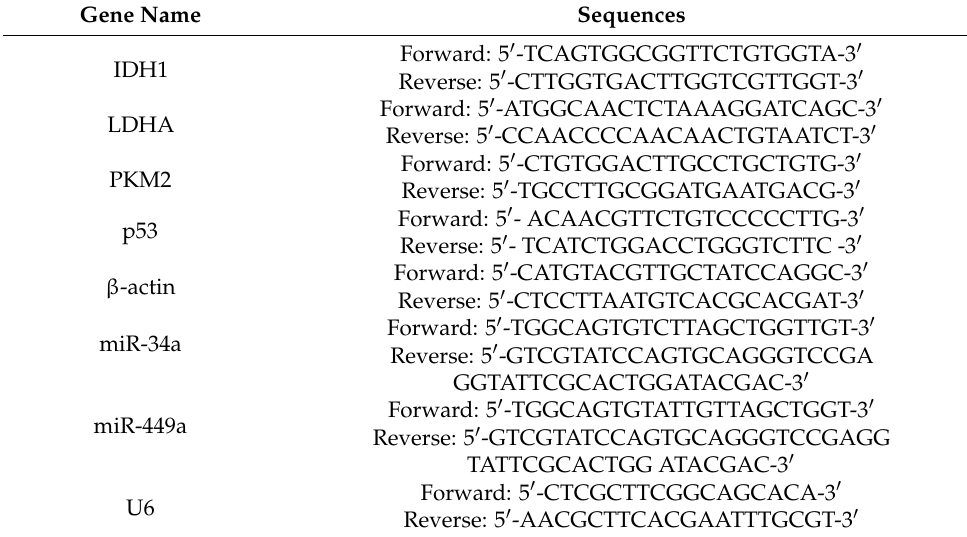
Table 1. The primer sequences for real-time